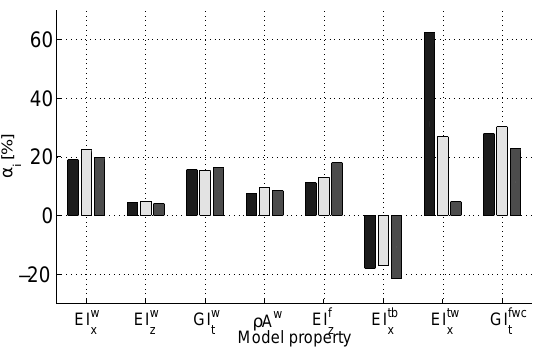
Fig. 10. Correction factors of the updated model: R&A dark gray, R&AV light gray, R&MAC medium